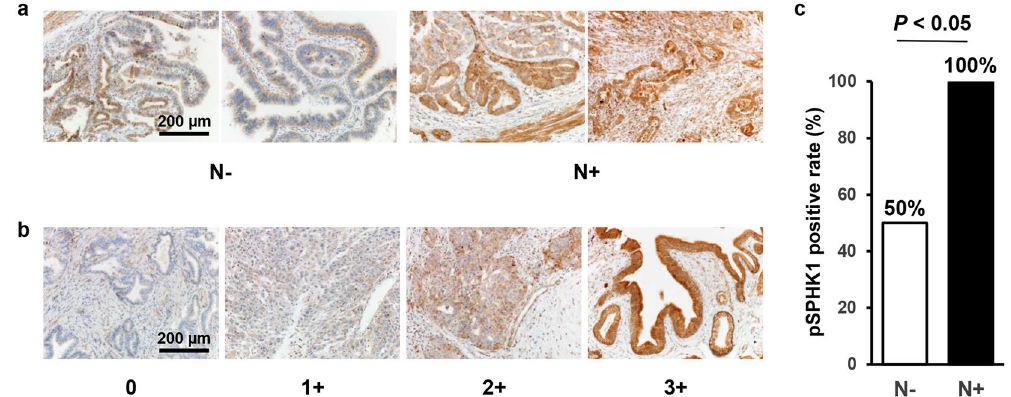
Figure 6. pSPHK1 is overexpressed in biliary tract cancer with lymph node metastasis on immunohistochemistry. ( a ) Semi-quantitative analysis of the immunohistochemical pSPHK1 expression in gallbladder cancer tissues with (n = 10) or without lymph node metastasis (n = 10) was performed. A staining score was calculated by multiplying two scores of staining intensity (0: negative staining; 1: weak staining; 2: moderate staining; 3: strong staining) and extent (0: 0–25%; 1: 26–50%; 2: 51–75%; 3: 76% -) of biliary tract cancer cells staining positive. The score of 0 to 5 was considered pSPHK1-negative, and 6 to 12 pSPHK1-positive. The score was compared between gallbladder cancer tissues with (n = 10) or without lymph node metastasis (n = 10) using Fisher’s exact test. The test was two-sided, and P value < 0.05 was considered statistically significant. Scale bar = 200 µ m. ( b ) The staining intensity was determined and scored as 0 (negative staining), 1 (weak staining), 2 (moderate staining) and 3 (strong staining). Scale bar = 200 µ m. ( c ) The result of immunohistochemical staining of pSPHK1 for gallbladder cancer with or without lymph node metastasis is